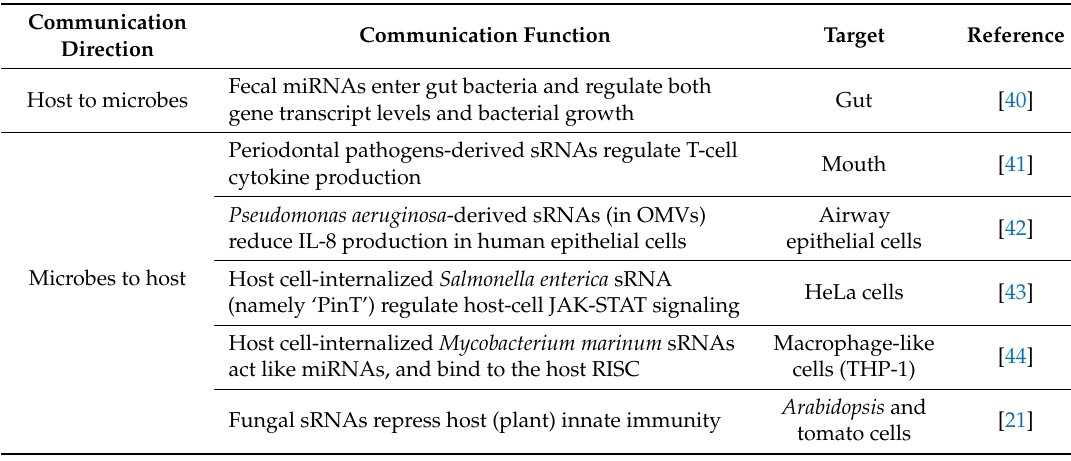
Table 1. Examples of host–microbe interspecies communication by extracellular